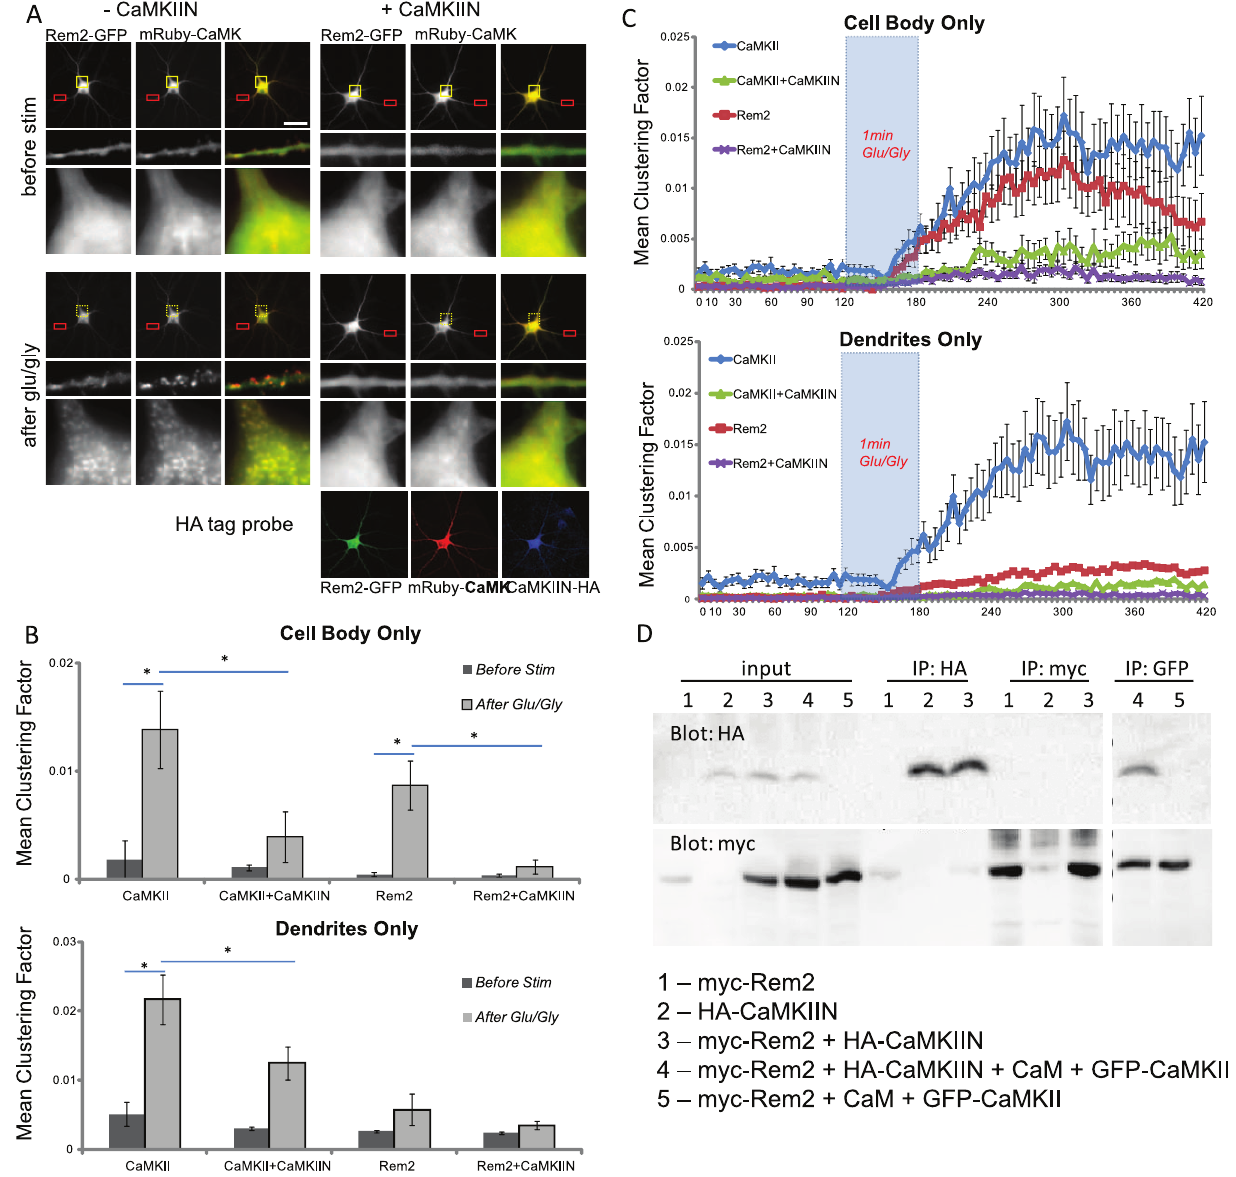
Figure 6. Rem2 and CaMKII redistribution is co-dependent. ( A ) CaMKIIN inhibits redistribution of Rem2 and CaMKII. Rat hippocampal neurons coexpressing ( left) GFP-Rem2 and (right) mRuby-CaMKII without (left panels) and with (right panels) HA-CaMKIIN. Cells were imaged before stimulation (top panels), then stimulated with 100 m M glutamate/10 m M glycine and imaged again (middle panels). Neurons were fixed and probed for HA to detect CaMKIIN (bottom panel). The scale bar represents 20 m m. ( B ) CaMKIIN reduces redistribution of coexpressed CaMKII and Rem2. Clustering factor determined as in [2]. Mean 6 SEM clustering factor for CaMKII without CaMKIIN: before stimulation, 0.004 6 0.002; after, 0.021 6 0.004; with CaMKIIN: before, 0.002 6 0.0002; after, 0.009 6 0.002. Rem2 clustering without CaMKIIN: before stimulation, 0.001 6 0.0002; after, 0.009 6 0.002; with CaMKIIN: before, 0.001 6 0.0002; after, 0.003 6 0.0006. Data is from 4 separate experiments with a total of N=27 neurons/condition. Error bars are 6 SEM; asterisks represent p , 0.05 (Kruskal-Wallis test followed by Tukey’s post hoc test). ( C ) Rem2 and CaMKII redistributions overlap temporally. A timecourse of aggregation of Rem2 and CaMKII shows little clustering before stimulation with glutamate/glycine, and Rem2 and CaMKII clustering occurs at similar rates. N=27 neurons/condition. ( D ) CaMKIIN does not interact with Rem2, and expression of CaMKIIN does not interfere with Rem2-CaMKII interaction. HEK cells were transfected with the indicated plasmids. Cell lysates were subjected to co-precipitation assays using a mix of proteinA/G beads and anti-HA,-myc or-GFP. Eluates were separated on SDS-PAGE and probed with anti-HA (top) and anti-myc (bottom). ( E ) CaMKII aggregates in HEK cells following a pH drop/high Ca protocol [2] (mean clustering factor before simulation 0.030 6 0.002; after 0.166 6 0.013). Aggregation is inhibited by CaMKIIN (before stimulation, 0.024 6 0.002; after, 0.068 6 0.010) but unaffected by coexpression of Rem2 (before, 0.031 6 0.003; after, 0.152 6 0.009). CaMKIIN inhibition is also insensitive to Rem2 coexpression (before, 0.031 6 0.003; after, 0.071 6 0.006). N=20 cells and p , 0.05 for all before-after pairs. ( F ) Rem2 does not aggregate using the same protocol (without CaMKIIN: before stim, 0.037 6 0.004; after, 0.032 6 0.004; with CaMKIIN: before, 0.018 6 0.002; after, 0.022 6 0.003), unless CaMKII is also present (without CaMKIIN: before stim, 0.012 6 0.002; after, 0.073 6 0.008). CaMKII-induced Rem2 aggregation is also inhibited by CaMKIIN (before, 0.008 6 0.001; after, 0.021 6 0.004). Error bars are 6 SEM; asterisks represent p , 0.05 (Kruskal-Wallis test followed by Tukey’s post hoc test).